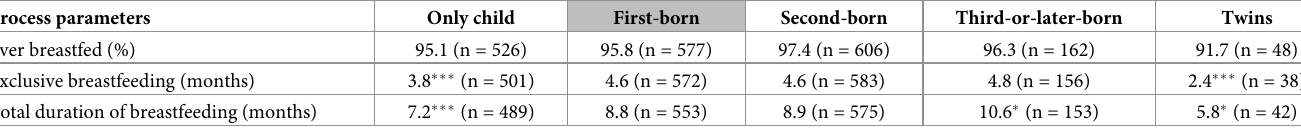
The table compares two groups, stratified according to birth order, in which siblings have an age difference of less or more than 3 years. Values are means ± standard error of the mean. The numbers in parentheses corresponds to the respective number of cases. First-born children served as the statistical reference group for each age gap group. SDS, standard deviation score.